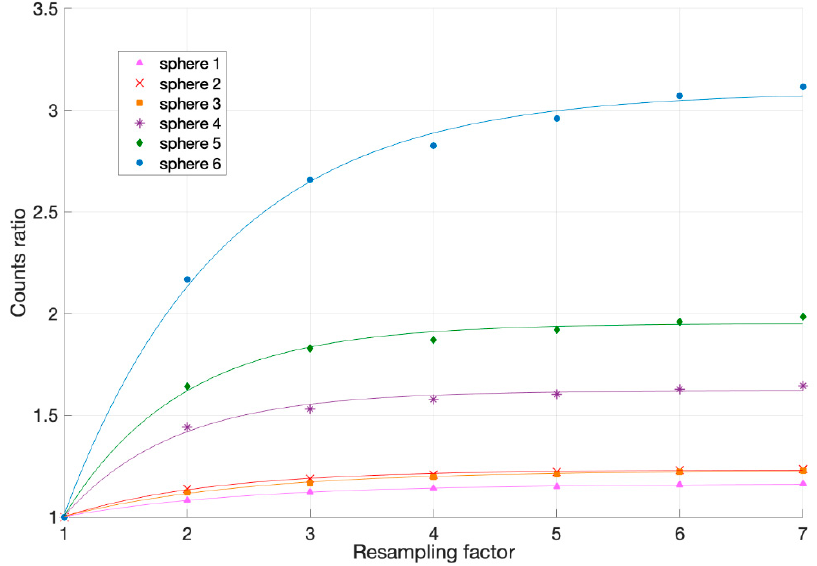
Figure 2. Counts ratio normalized to the original counts at the increasing of the voxel division of the starting matrix (256 × 256 × 47) for each sphere, marked in different color with different markers.